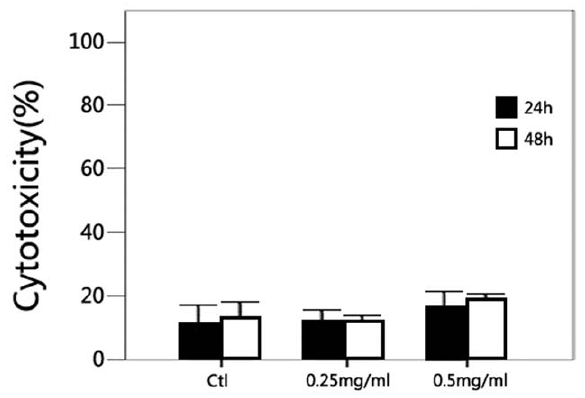
Figure 3. Cytotoxicity of pirfenidone in a LDH assay. After 24 or 48 hours’ treatment with PFD (0, 0.25, and 0.5 mg/ml), no statistically significant difference was found between the percentage of cell- mediated lysis in PFD treated groups and control group ( P . 0.05). Data are the mean 6 SD of triplicates from an experiment that was repeated with similar results.